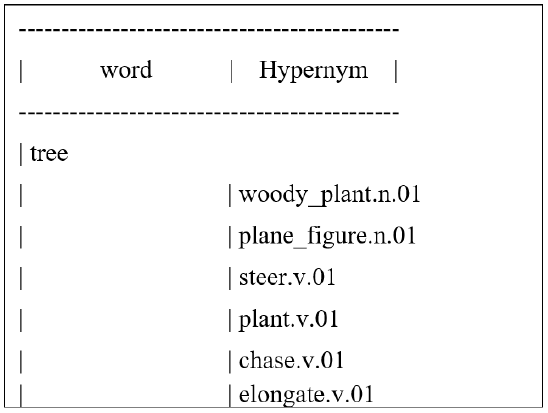
Figure 4. All hypernyms of a word “tree” as extracted from WordNet.